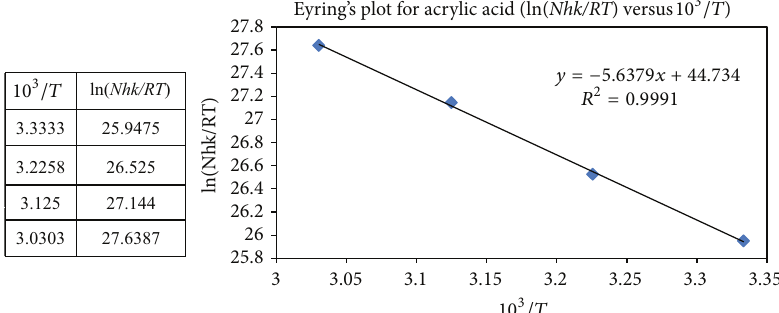
Figure 7: Eyring’s plot of acrylic acid (ln (𝑁ℎ𝑘/𝑅𝑇) versus 10 3 / 𝑇 ). Kinetic study with [Phen] = 3.75 × 10 −3 mol dm −3 ; [PEG-300] = 6.24 × 10 −1 moldm −3 ; [Fe(III)] = 1.25 × 10 −3 moldm −3 .